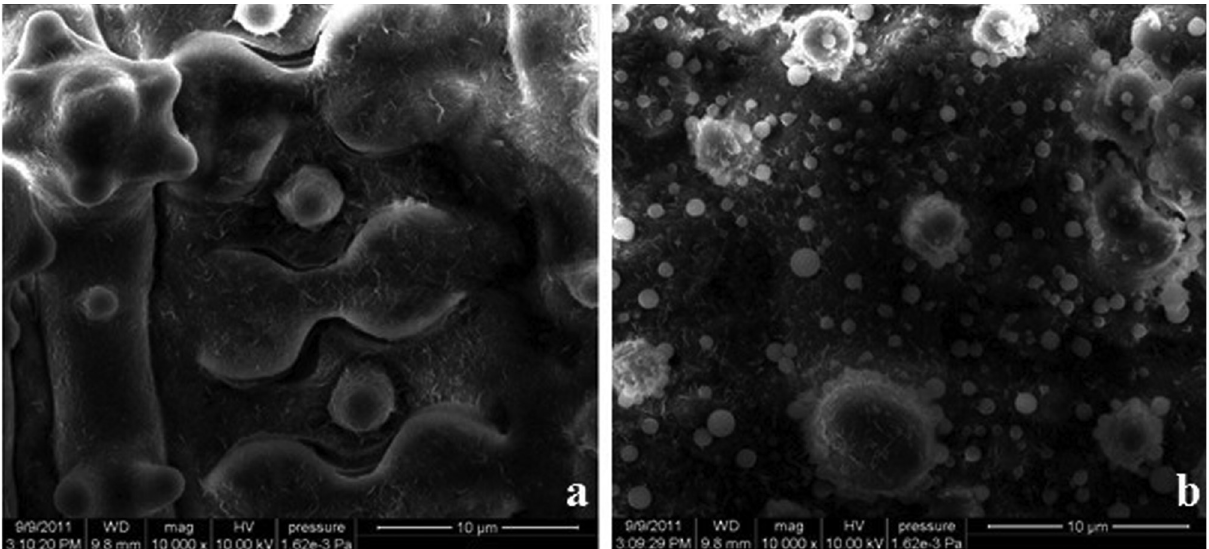
Figure 2 - Scanning electron micrographs of the surface of wild-type (a) and spl30 mutant (b) leaves.